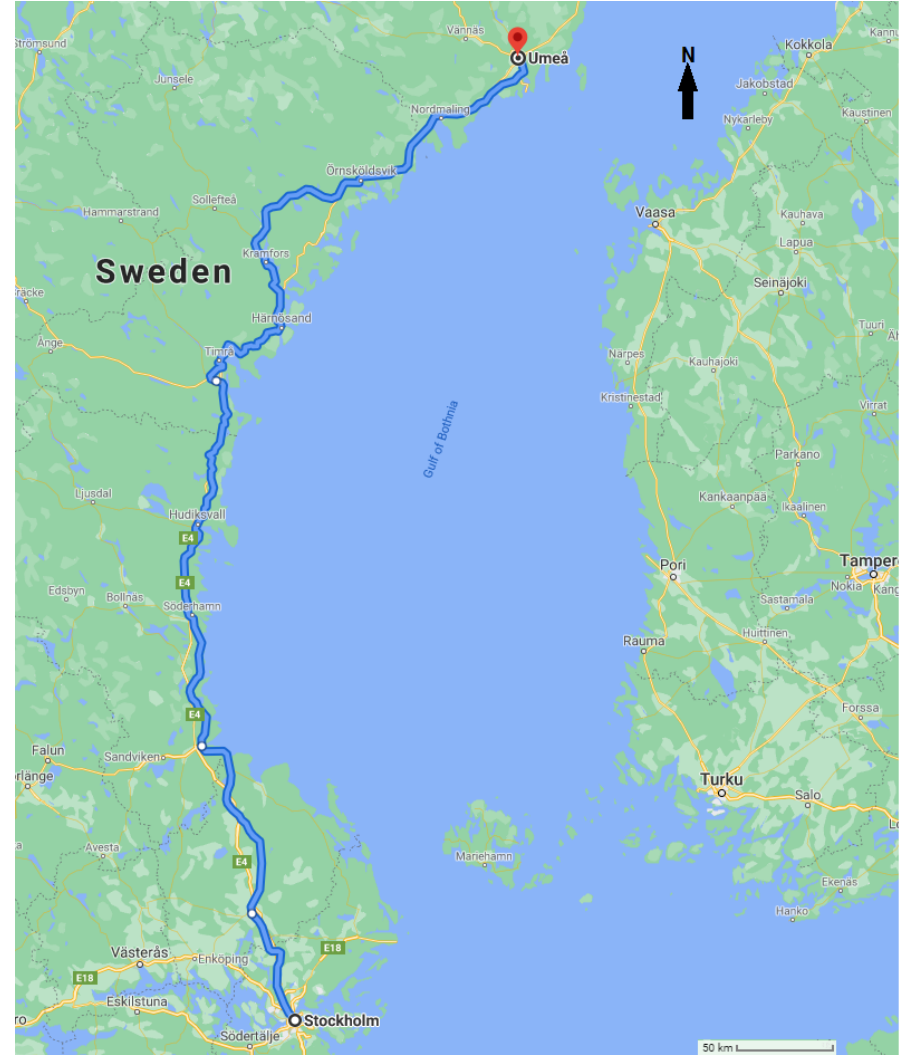
Figure 2. Train line in the region with simulated WRF